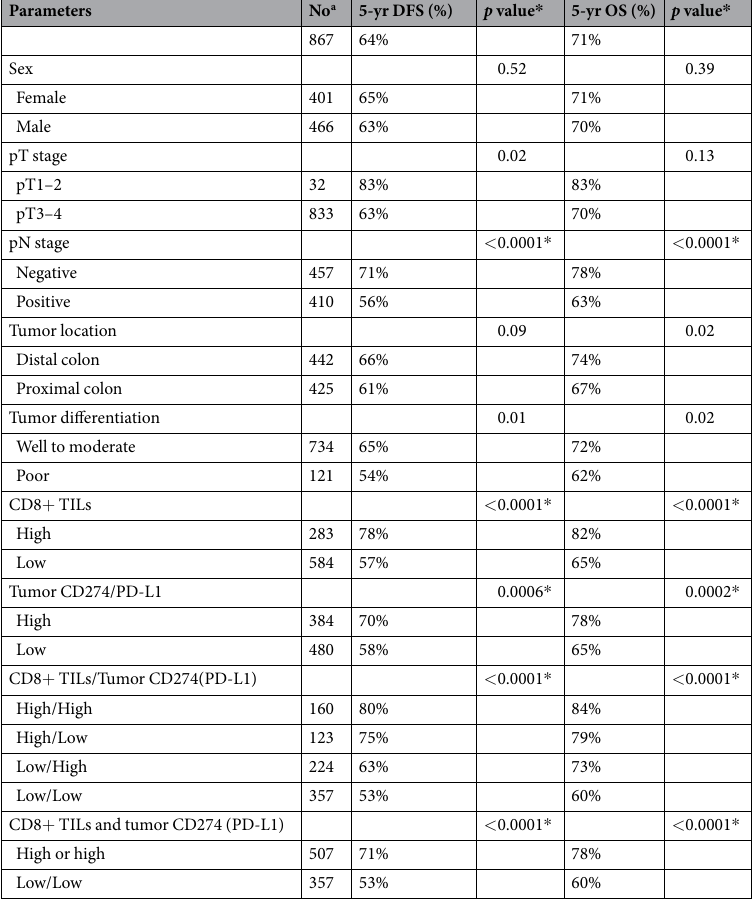
Table 3. Correlation between clinicopathologic parameters, 5-year DFS and 5-year OS. a Number of cases may differ due to missing data. * p < 0.005 is significant and 0.005 < p < 0.05 is suggestive